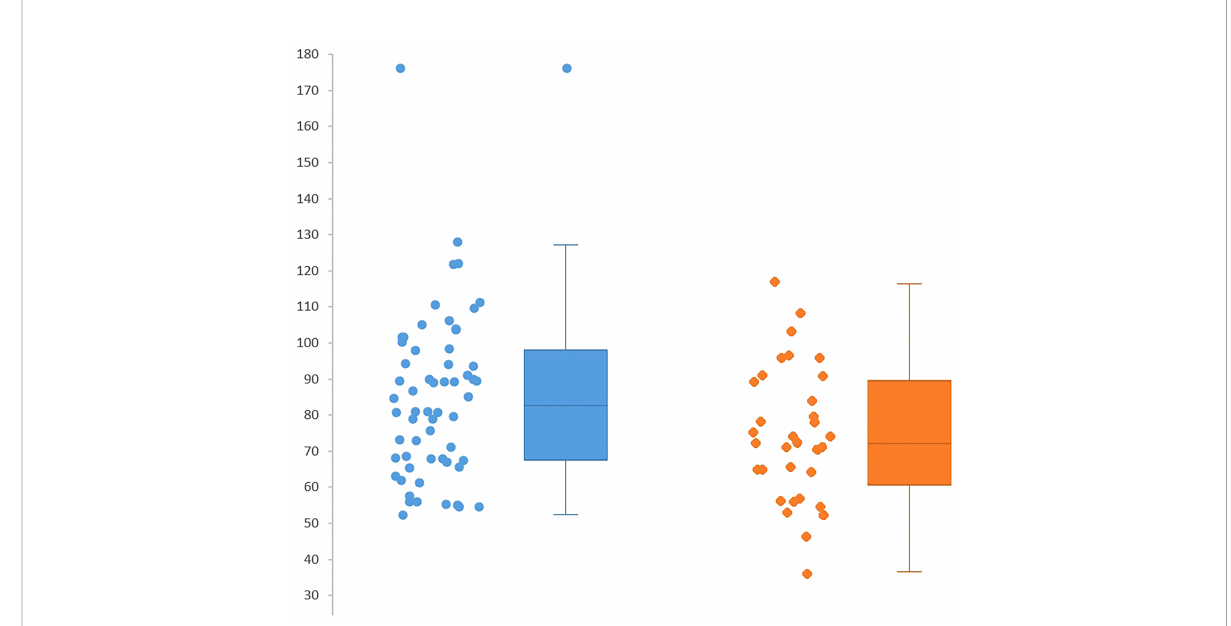
FIGURE 3 ppoFEV1 and ppoFVC evaluations in complications group vs complication